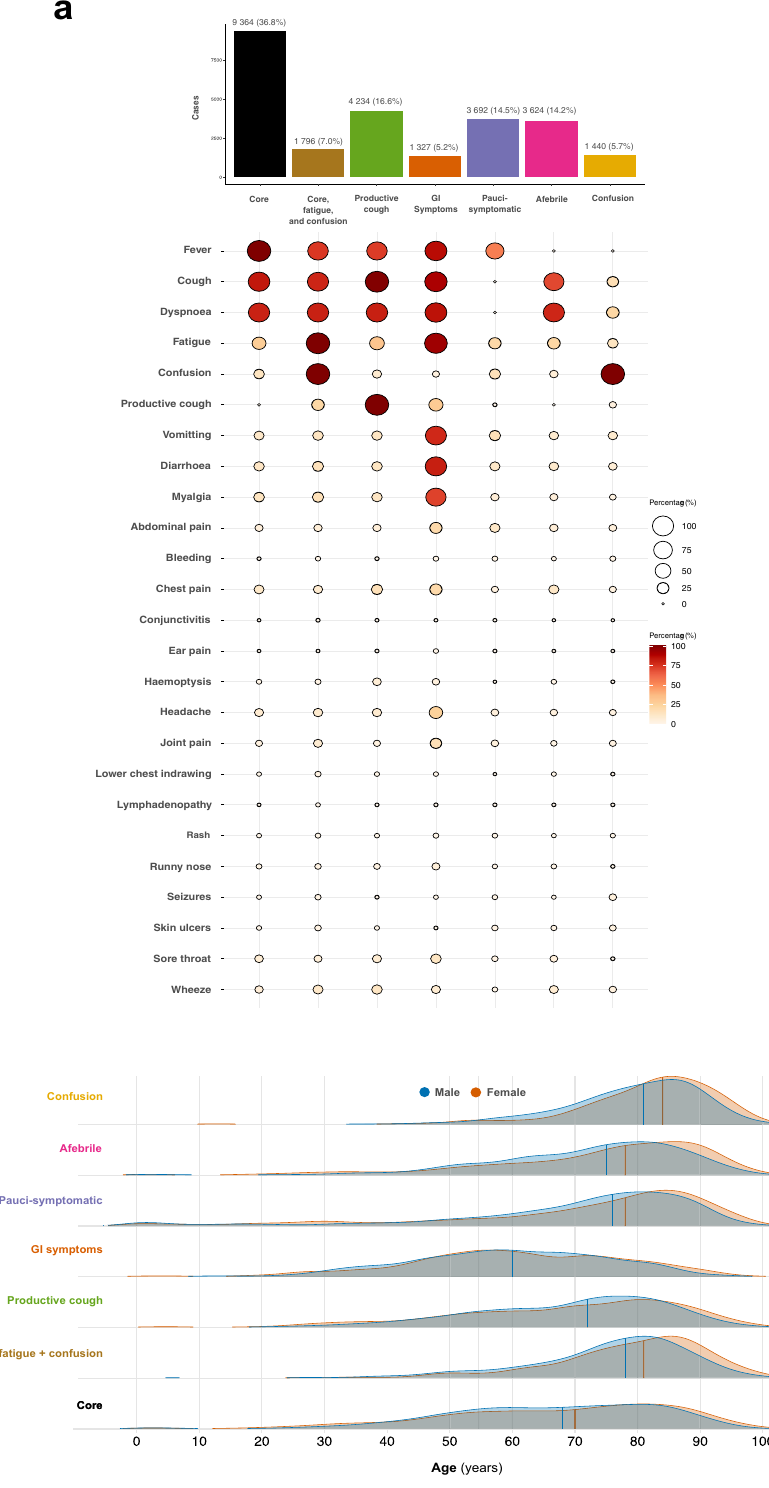
Figure 2. Symptom clusters. ( a ) Cluster identities, proportions, and patterns. Data are presented as count (percentage). ( b ) Distribution of age by symptom cluster. Density plots, solid lines represent the median